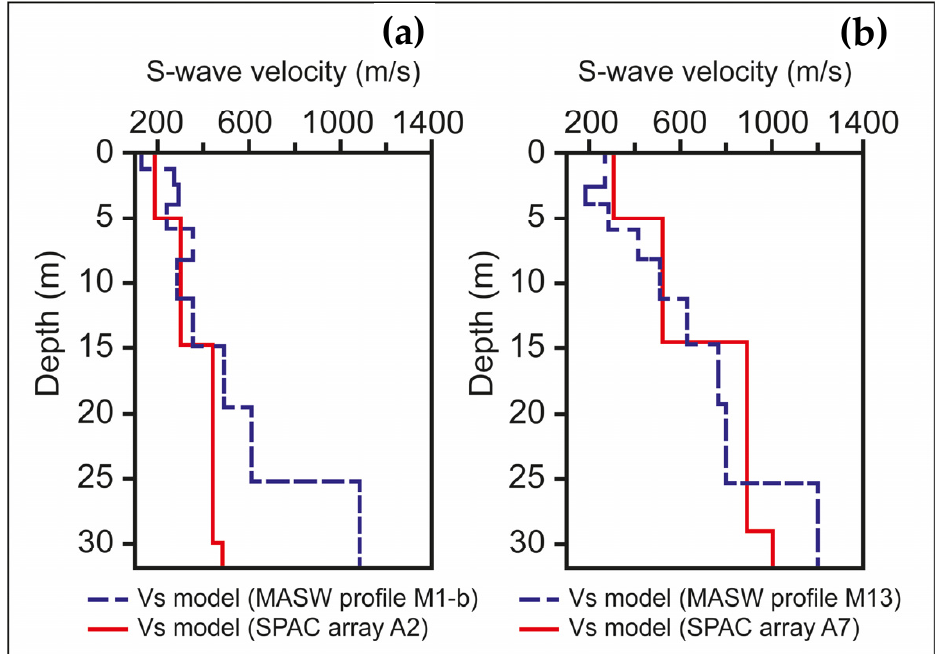
Figure 12. Examples of SPAC and MASW 1D Vs model comparison: ( a ) MASW profile M1-b vs. SPAC array A2; and ( b ) MASW profile M13 vs. SPAC array A7. (See locations in Figure 2). Table 4. Mean slope (%) for a 200 m resolution DEM and Mean V s30 values (m/s), within each geological unit. V s30 estimation methods: Wald and Allen (2007) [26] for tectonically active